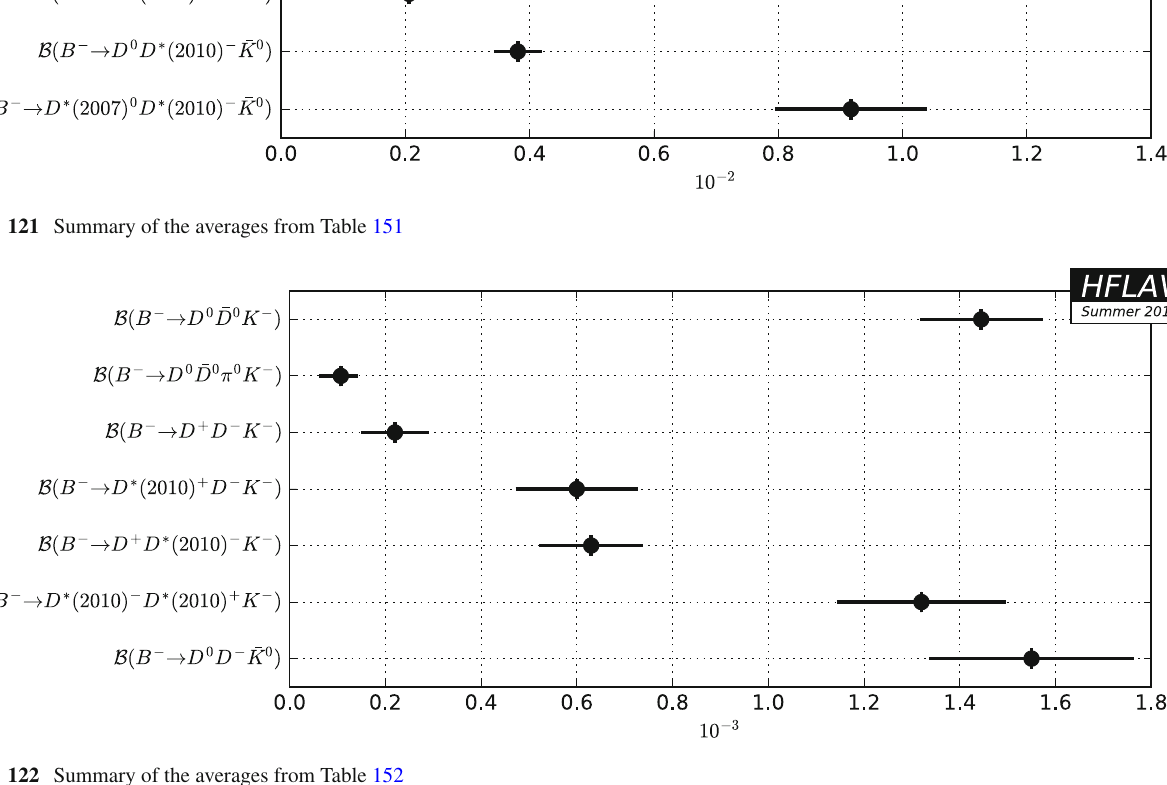
Fig. 122 Summary of the averages from Table